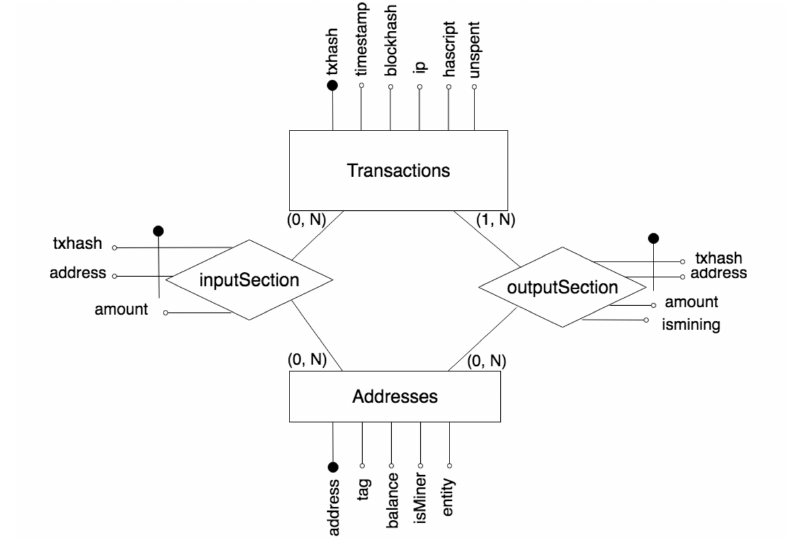
Figure 2. E-R diagram of the relational database target of the transformed